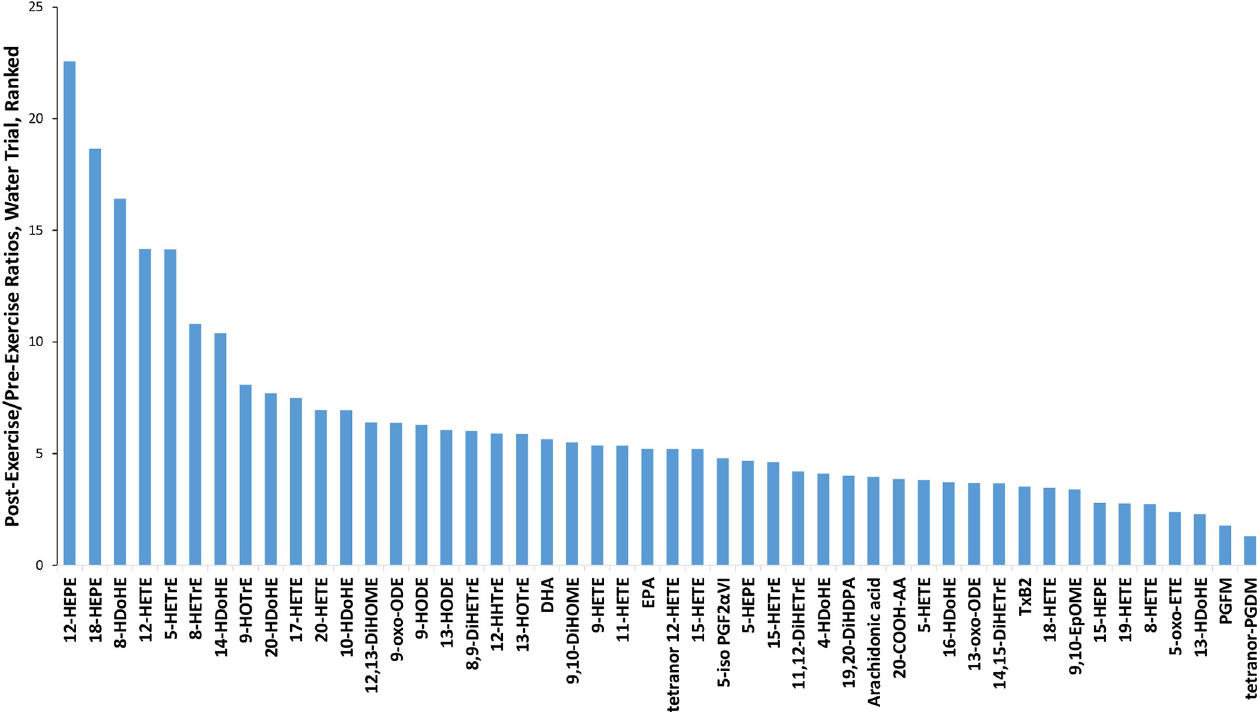
Fig 3. Ratio values (immediate post-exercise/pre-exercise) for N = 45 oxylipins, ARA, EPA, and DHA using data from the water trial. Significant time effects (P < 0.05) were measured for each except 5-oxoETE (P = 0.139) and tetranor PGDM (P = 0.267).